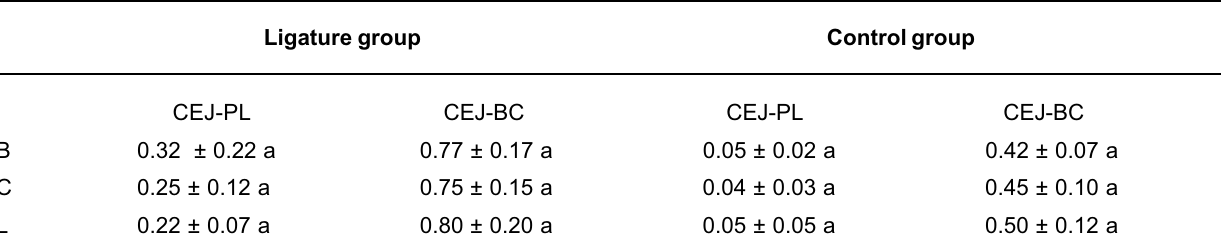
TABLE 1- Means (±SD) (in mm) of histometric attachment level (distance between CEJ and PL) and bone level (distance between CEJ and BC) in both groups distributed according to the depth of the histological sections (buccal (B), central (C) and lingual (L) regions, 10 sections per region)